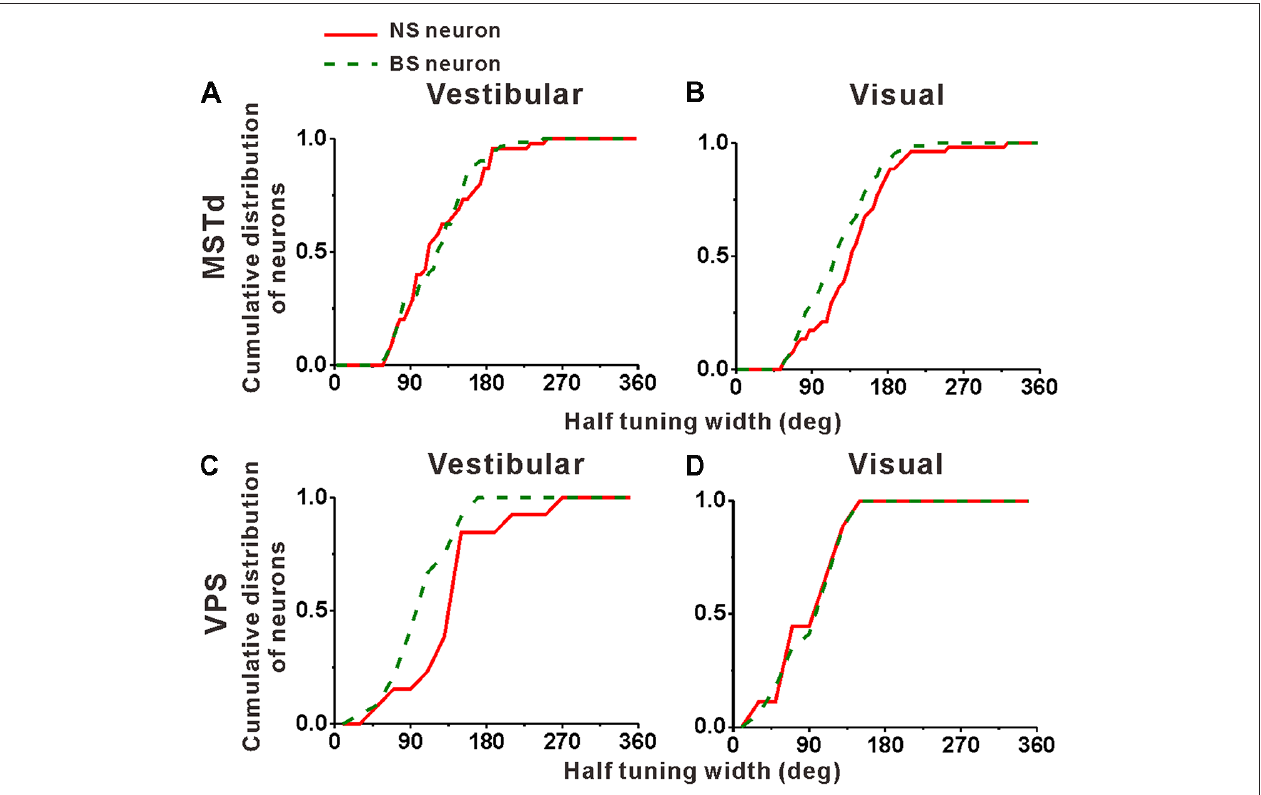
FIGURE 6 | Population summary of the half tuning width of the NS (red) neurons and BS (green) neurons in areas MSTd (A,B) and VPS (C,D) under the vestibular and visual conditions. Cumulative frequency distribution of the neurons on the half tuning widths, which were computed from each neuron’s tuning curve in the horizontal plane, are given by the curves. The neurons analyzed in the graph have a significant directional tune to vestibular or visual stimuli (both p < 0.05, ANOVA test). The number of neurons were same as in Figure 4 .